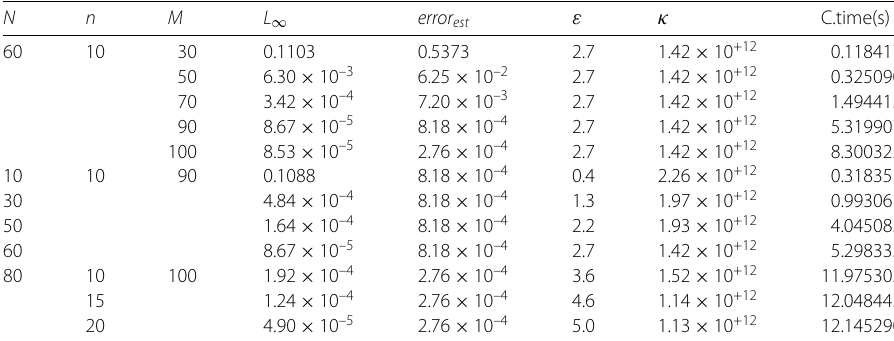
Table 3 The results are obtained for α = 0.3, x ∈ [–1,1], and t = 1